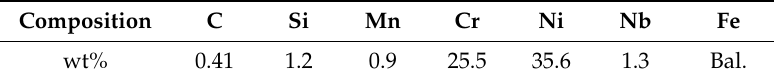
Table 1. Chemical composition of failed specimens.